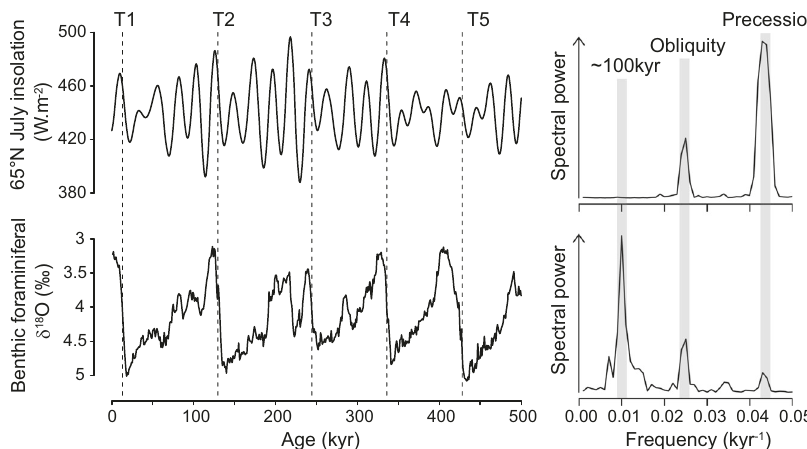
Fig. 1 The 100 kyr problem. The geologic record of benthic foraminiferal δ 18 O 65 contains signi fi cant spectral power in the eccentricity band (as well as those of precession and obliquity) while the external insolation forcing at this period (~100 kyr) is negligible. Late Pleistocene glacial cycles are ‘ terminated ’ by relatively short deglacial periods, giving rise to a characteristic saw-tooth character. T1 – T5 represent Terminations 1 to